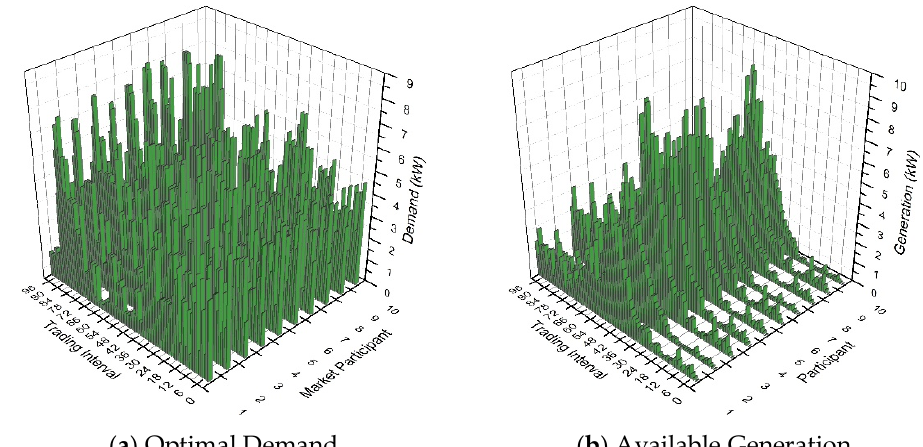
Figure 6. Participant’s daily demand and generation pattern.